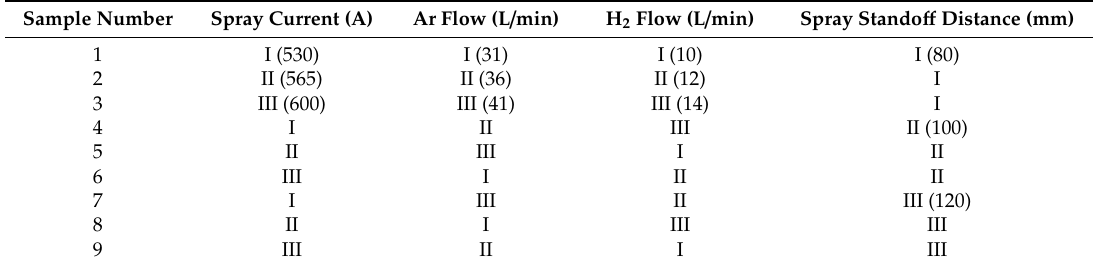
Table 2. Designed parameters combination in orthogonal experiments of AT13 coatings.